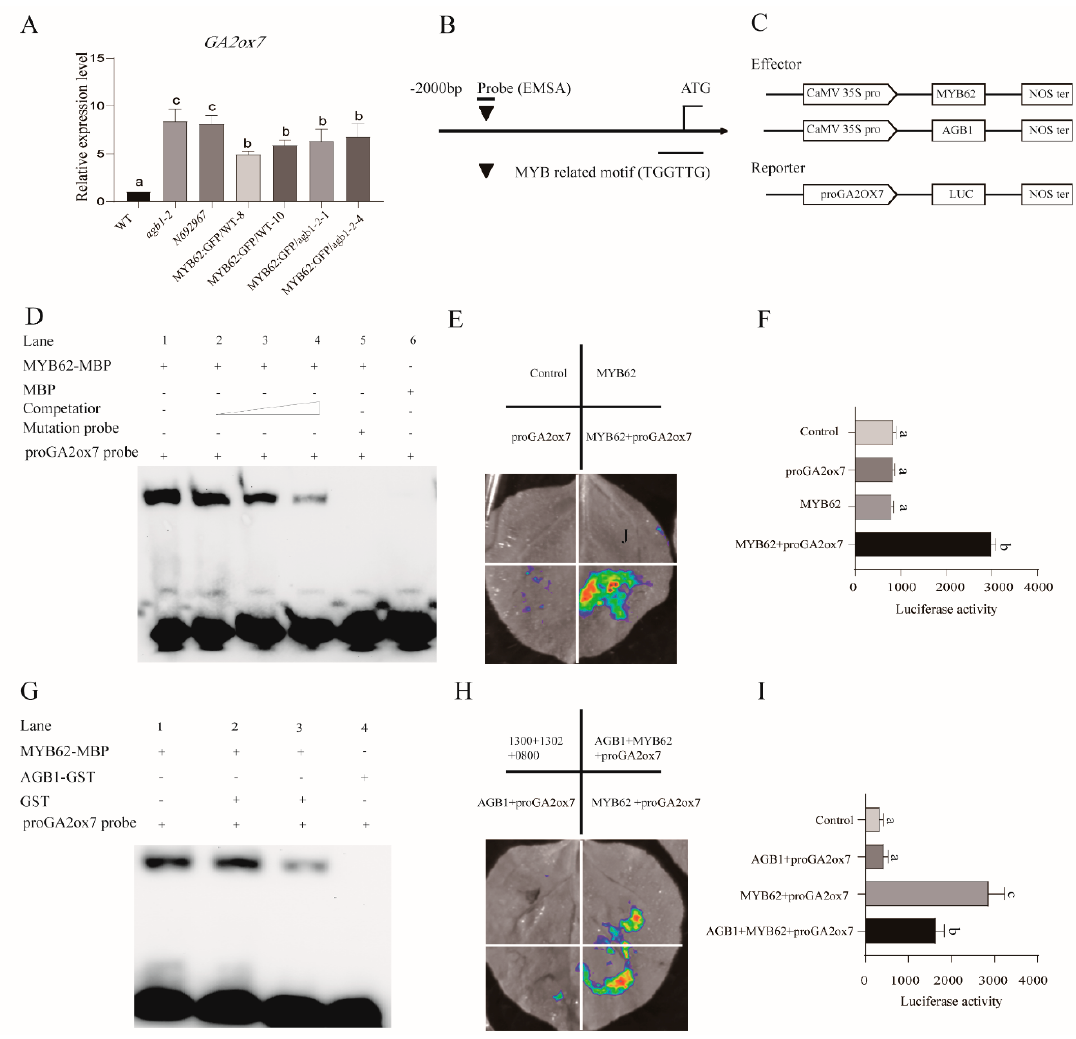
Figure 6. AGB1 negatively regulates the expression of the downstream genes of MYB62 . ( A ) The GA degradation-related gene, GA2ox7 , in the wild-type ( Col-0 ), agb-1-2 , N692967 , MYB62 :GFP/WT-8, MYB62 :GFP/WT-10, MYB62 :GFP/ agb1-2 - 1 , and MYB62:GFP/agb1-2 - 4 revealed by qRT-PCR analysis under GA 3 treatment. Error bars represent the means ± SE (n = 3). Significant differences were analyzed using Duncan’s multiple range test ( p < 0.05). Relative quantitative results were calculated by normalization using the control gene ACT2 (AT3G18780). ( B ) Illustration of the MYB62 promoter region showing the presence of the MYB-binding site. ( C ) Schematic diagram of the effectors and the reporter structure of LUC (luciferase analysis) in E and H. ( D ) The EMSA (electrophoretic mobility shift assay) experiment showed that MYB62 could bind to the promoter of GA2ox7 . ( E ) The LUC experiment showed that MYB62 could bind to the GA2ox7 promoter and promote the expression of GA2ox7 ; 302 indicates the pCambia 1302 vector, and 0800 indicates the pGreenII 0800-LUC vector. Representative images of N. benthamiana leaves were taken 48 h after infiltration. All experiments were repeated three times with similar results. ( F ) Quantification of luminescence intensity in E. Error bars represent the means ± SE (n = 3). Significant differences were analyzed using Duncan’s multiple range test ( p < 0.05). ( G ) The EMSA experiment showed that AGB1 negatively regulates the binding of MYB62 to the e GA2ox7 promoter. ( H ) The LUC experiment showed that AGB1 could negatively regulate the binding of MYB62 to the GA2ox7 promoter and negative regulately the expression of GA2ox7 ; 1300 indicates the pCambia 1300 vector, 1302 indicates the pCambia 1302 vector, and 0800 indicates the pGreenII 0800-LUC vector. Representative images of N. benthamiana leaves were taken 48 h after infiltration. All experiments were repeated three times with similar results. ( I ) Quantification of luminescence intensity in H. Error bars represent the means ± SE ( n = 3). Significant differences were analyzed using Duncan’s multiple range test ( p <